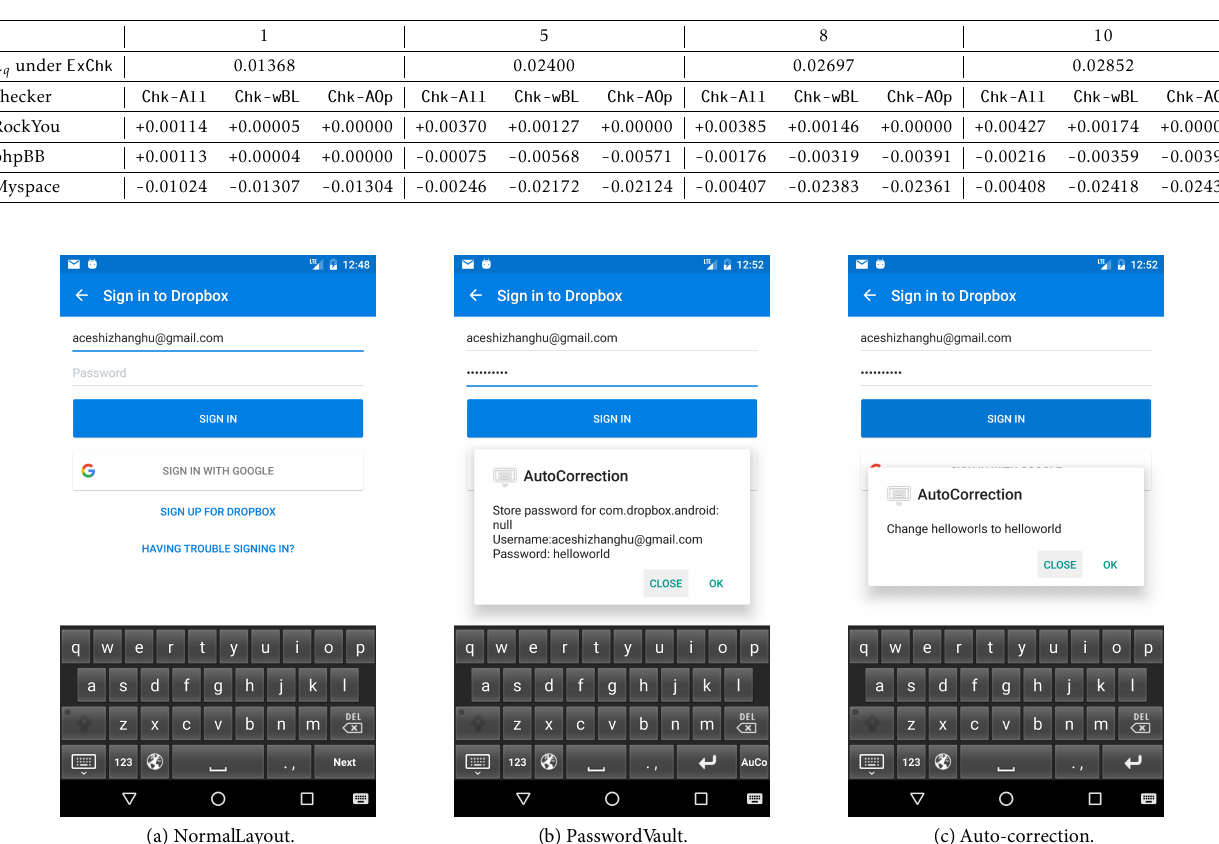
Figure 2. Screen-shots of a Dropbox login process. The pop-updialogs are for the purposeof demonstration and do not appear in the real